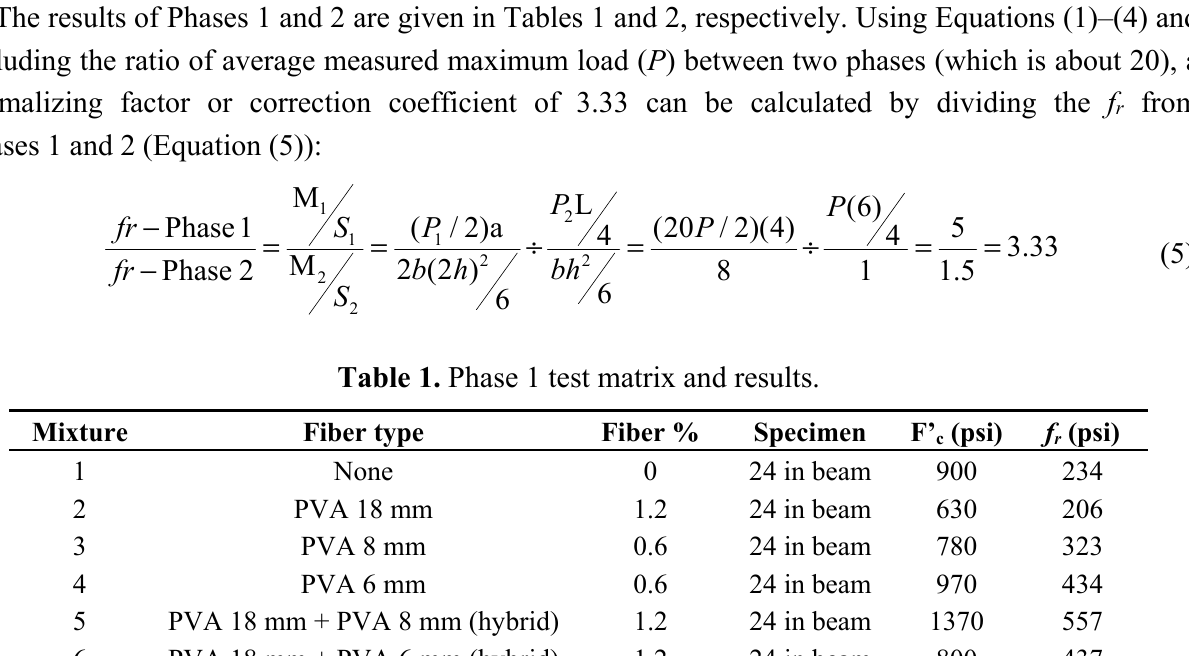
Figure 2. (Left) Phase 1: flexural test setup and photo of failed FRM specimen; (Right) Phase 2: small specimen flexural test setup and photos from the test